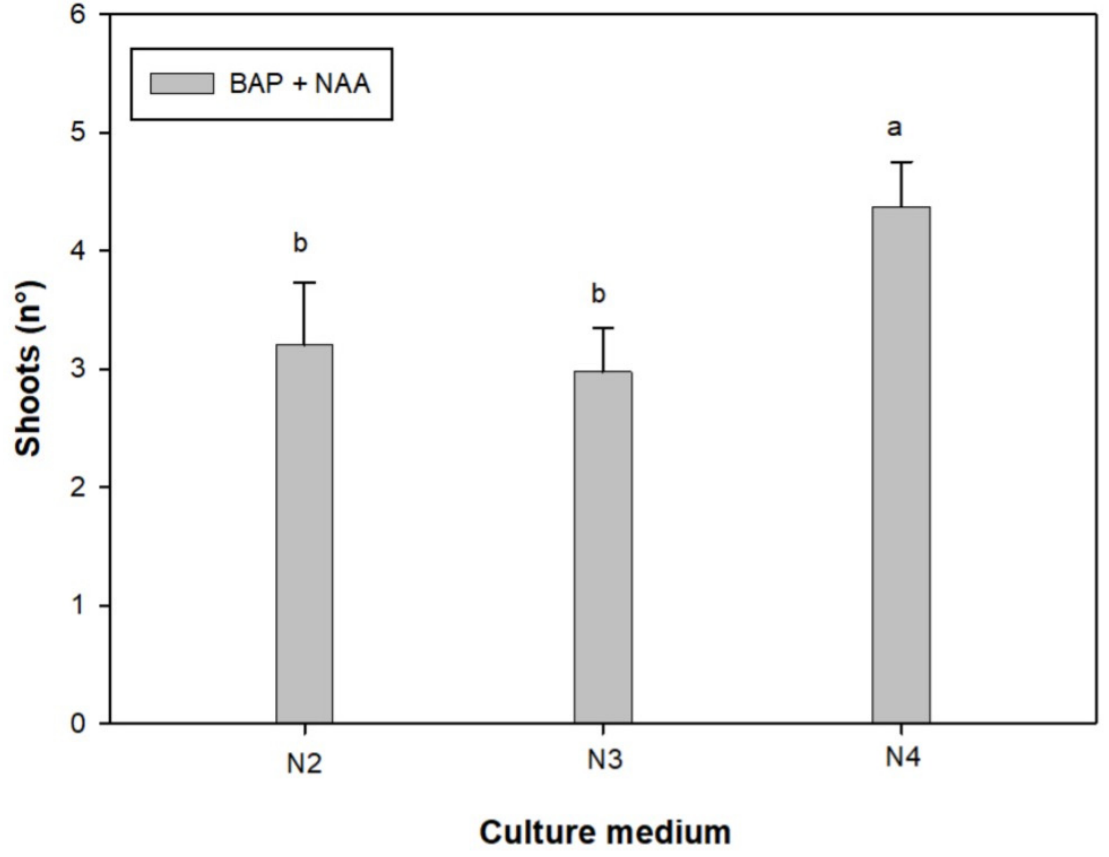
Figure 3. Effect of different PGR concentrations on the number of shoots per explant. Bars represent standard error. The different letters reported above the bars indicate statistically significant differences between each culture medium tested (Tukey’s test, p ≤ 0.05). N2 (medium with 1 mg L − 1 BAP + 1 mg L − 1 NAA); N3 (2 BAP + 1 NAA); N4 (3 BAP + 1 NAA).